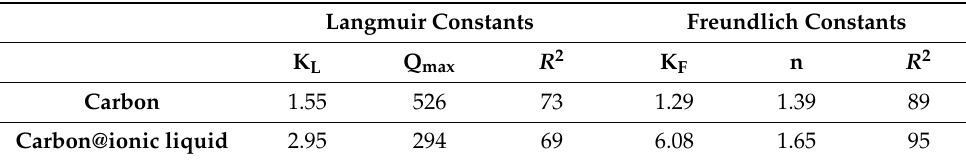
Table 2. Langmuir and Freundlich constants for the adsorption of benzothiophene onto carbon and carbon@ionic liquid. Langmuir